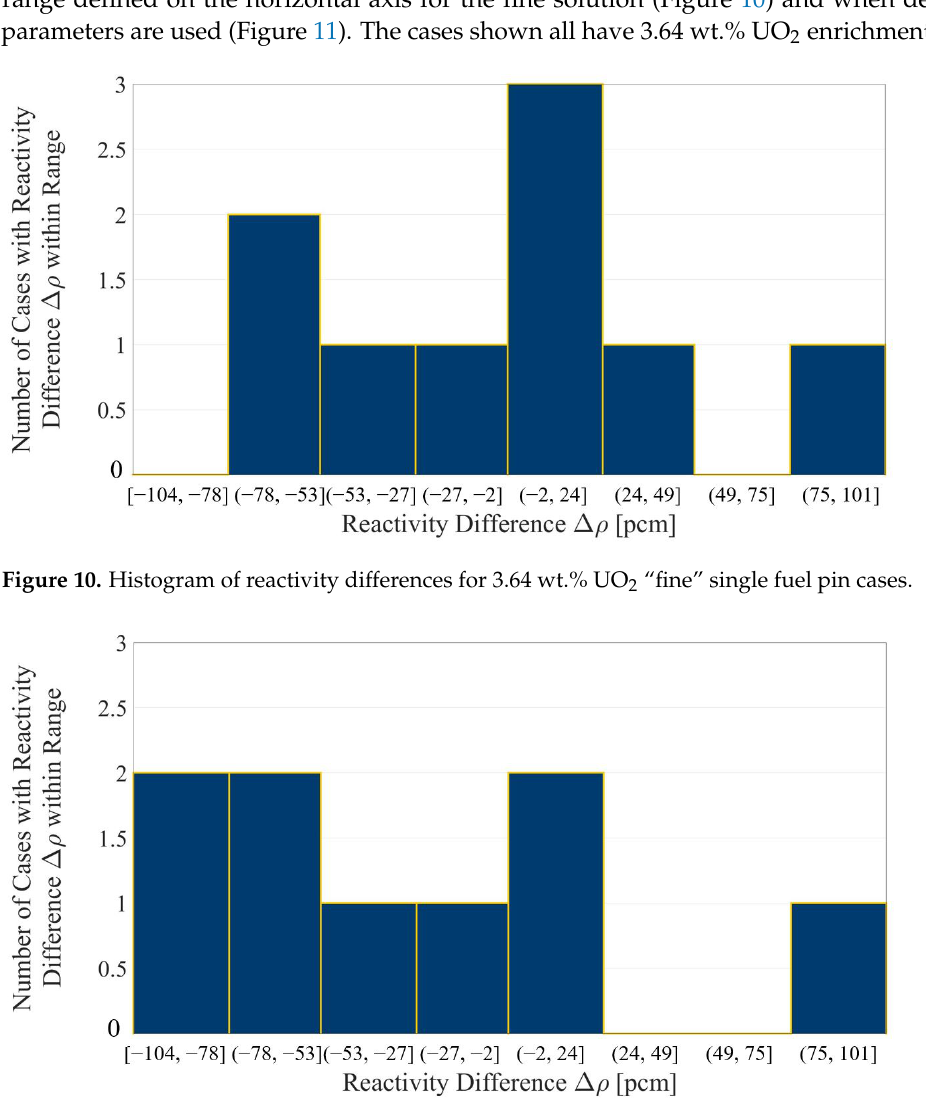
Figure 11. Histogram of reactivity differences for 3.64 wt.% UO 2 single fuel pin cases using default